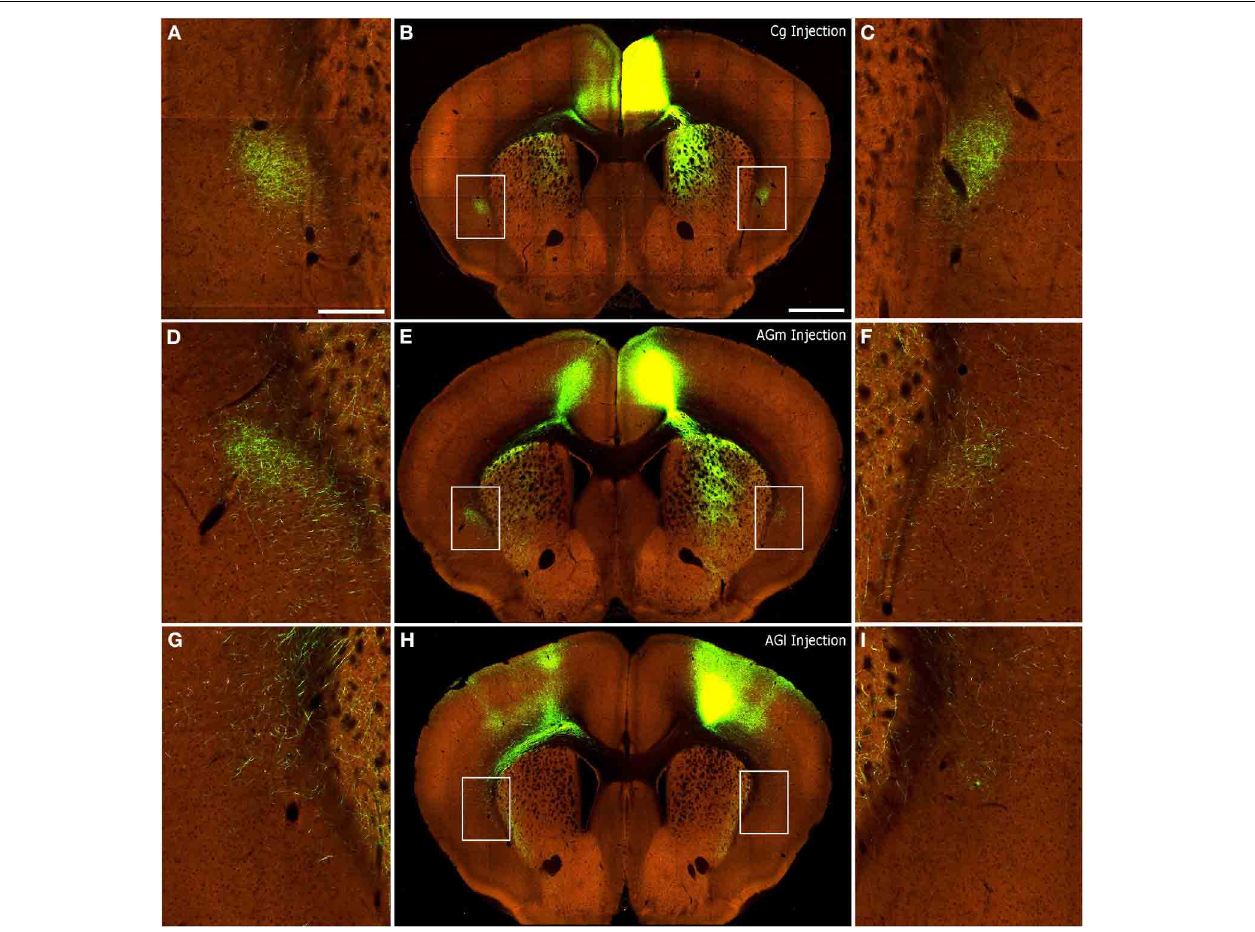
FIGURE 8 | Corticoclaustral projections from Cg, AGm, and AGl in mice. Images of AAV injections and subsequent labeling acquired from the Allen Mouse Brain Connectivity Atlas (2012). Center panels show images of labeling from representative AAV tracer injections in Cg (B) , AGm (E) , and AGl (H) . Hyperlinks connect to the complete data sets on the Allen Institute